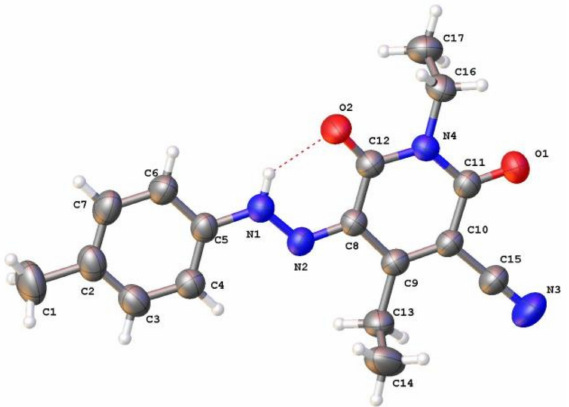
Figure 7. ORTEP of dye 30b .